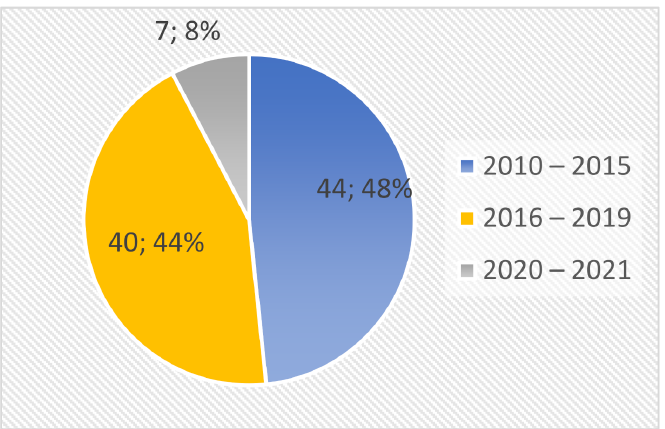
Figure 3. Article Sharing Rate based on the Number of publication